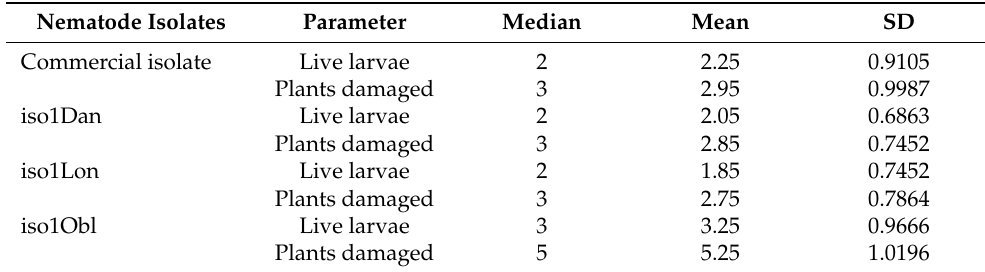
Table 2. Mean number of live Z. tenebrioides larvae and damaged plants per m 2 after 14 day exposure to four isolates of S. feltiae